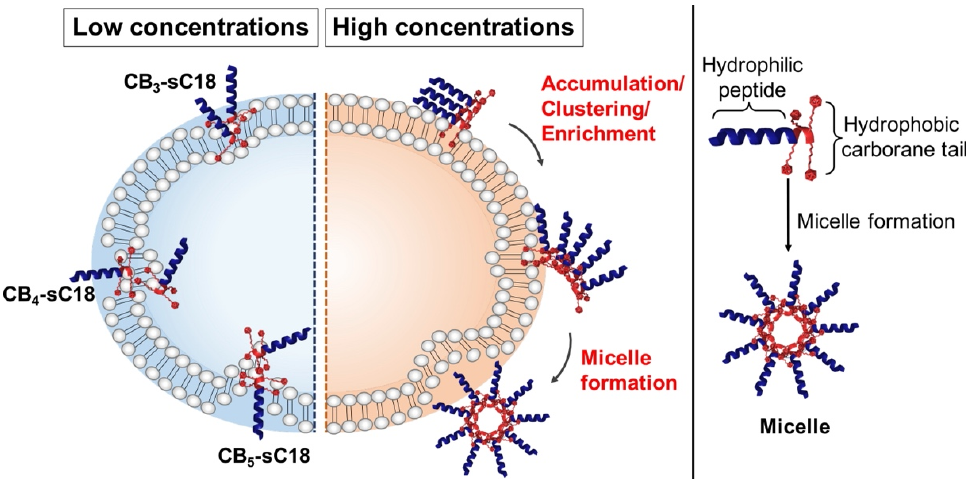
Figure 5. The hypothetical mechanism of interaction of CB-peptide conjugates with cellular membranes is demonstrated. Not shown is endocytosis, which we observed as one of the preferred internalization pathways (see Figure 3). Left: low concentrations of CB-CPP conjugates interact with the outer surface of the plasma membrane, leading to pore formation events and potential membrane distortion. Right: high concentrations of CB-peptide conjugates might result in potential self-assembly processes.